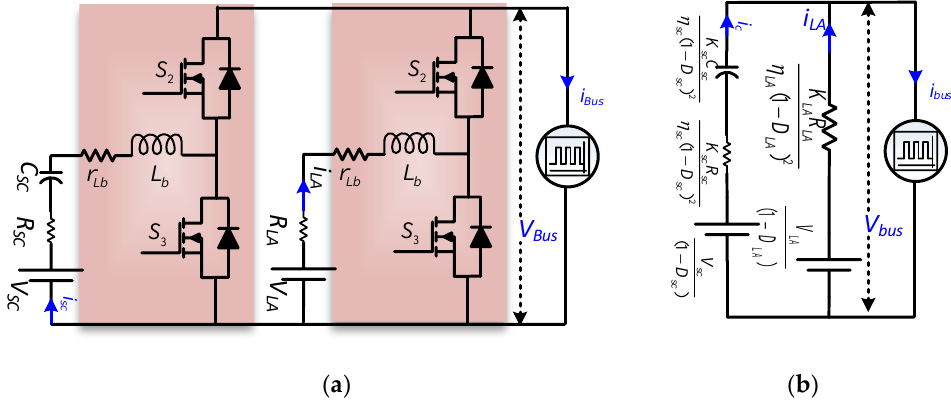
Figure 12. ( a ) full-active HESS ( b ) equivalent circuit.